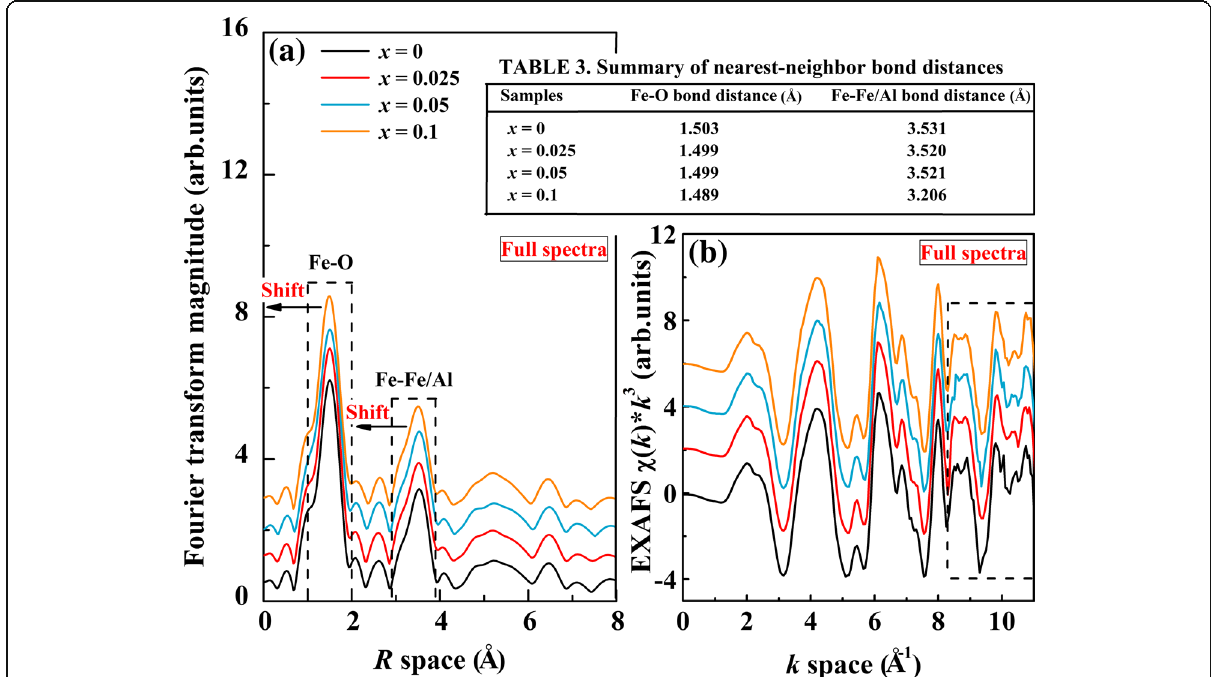
Fig. 4 a Fourier transforms of Fe K -edge k 3 -weighted EXAFS data, for the BFA x O (0 ≤ x ≤ 0.1). b EXAFS χ ( k ) × k 3 spectra of BFA x O (0 ≤ x ≤ 0.1). The spectra were aligned along the Y -axis for better